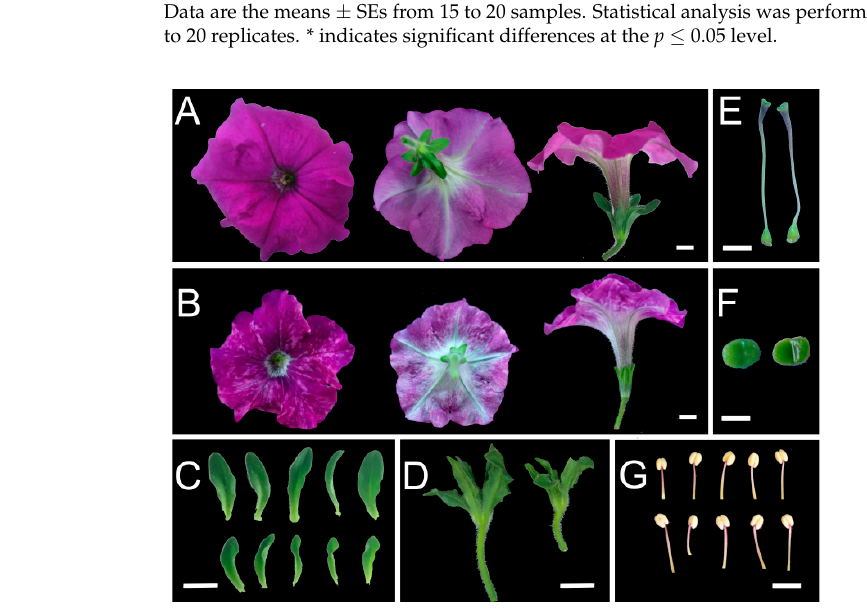
Table 1. Effects of PhSK silencing on petunia plant growth. pTRV2-GFP pTRV2- PhSK